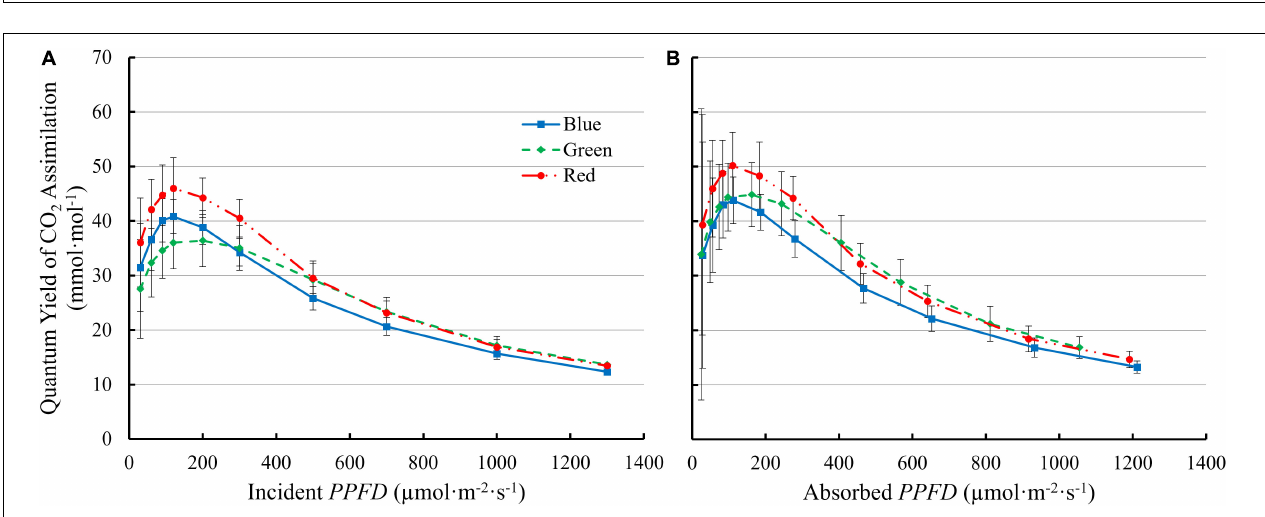
FIGURE 5 | Maximum gross assimilation rate ( A g , max ) of “Green Towers” lettuce under different light spectra, calculated from the light response curves. Bars with the same letter are not statistically different ( p ≤ 0.05). Error bars represent standard deviation ( n = 9). The composition of the nine light spectra is shown in Table 1 .